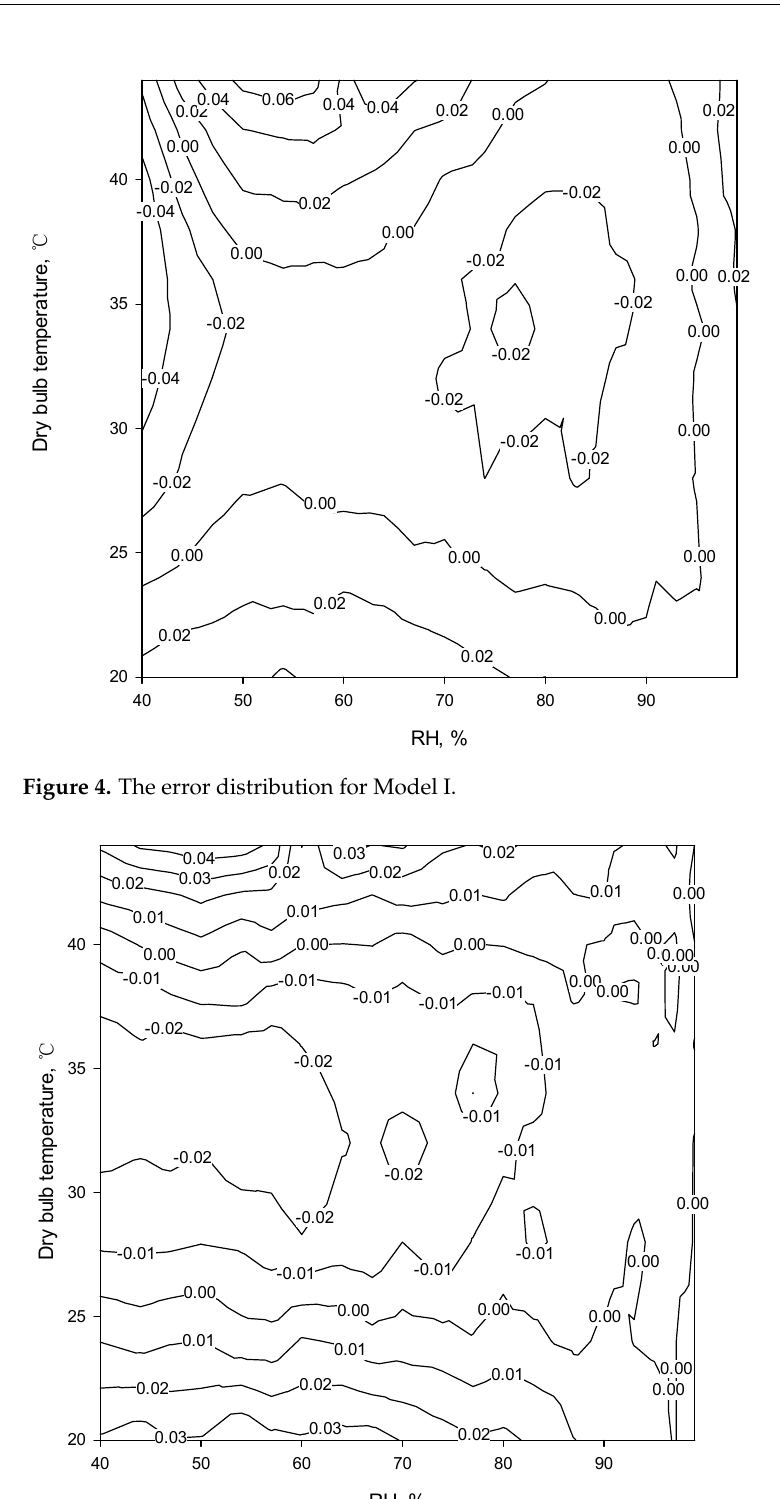
Figure 6. The relationship between Td and RH for a threshold of heat stress of 35 °C. To ensure the safety of human beings, if the air humidity is 80%, the Td value must be <38.3 °C. If the air humidity is 90%, the Td value must be <36.6 °C. However, the meas- urement errors for Td and RH are not considered. This study uses the concept of meas- urement uncertainty to determine the effect of measurement errors for Td and RH on the Tw calculation [38,39]. The uncertainty in Tw is calculated as: